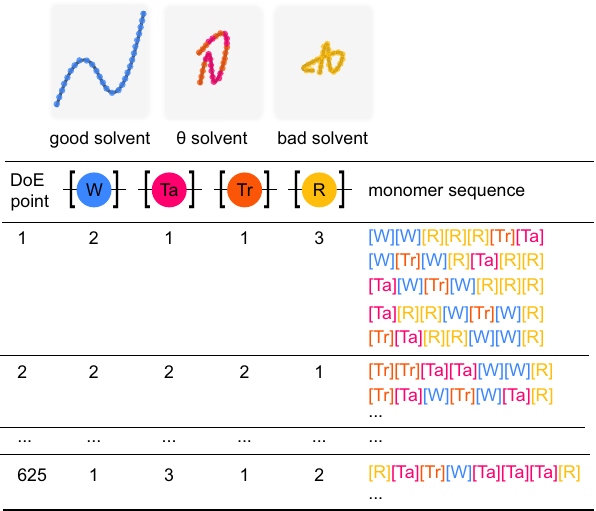
Fig. 3 Illustration of the DoE approach. The beads of our coarse-grained model have different interactions with the solvent. The “ [W] ” bead corresponds to a polymer in a good solvent, the “ [R] ” bead to a polymer in a bad solvent, and the “ [Ta] ” and “ [Tr] ” beads to polymers in a theta solvent. “ [Tr] ” and “ [Ta] ” differ from each other in their interaction with the surface. For each DoE point, which speci fi es the composition of a polymer, we sample fi ve arrangements of monomers. This results in a design space of 3125 polymers in total. Note that the polymers that we sampled had at minimum 4 units of each